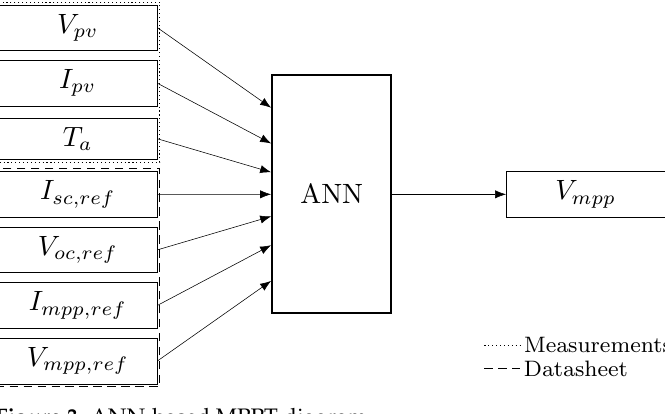
Figure 3. ANN-based MPPT